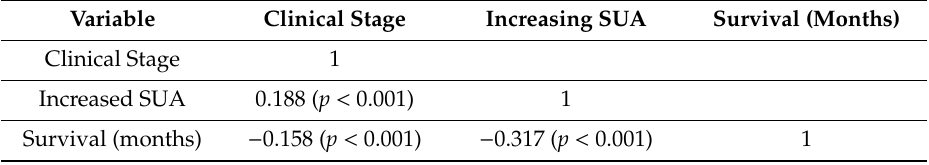
Table 7. Pearson correlation coefficient analysis of clinical stage, increased uric acid, and survival.